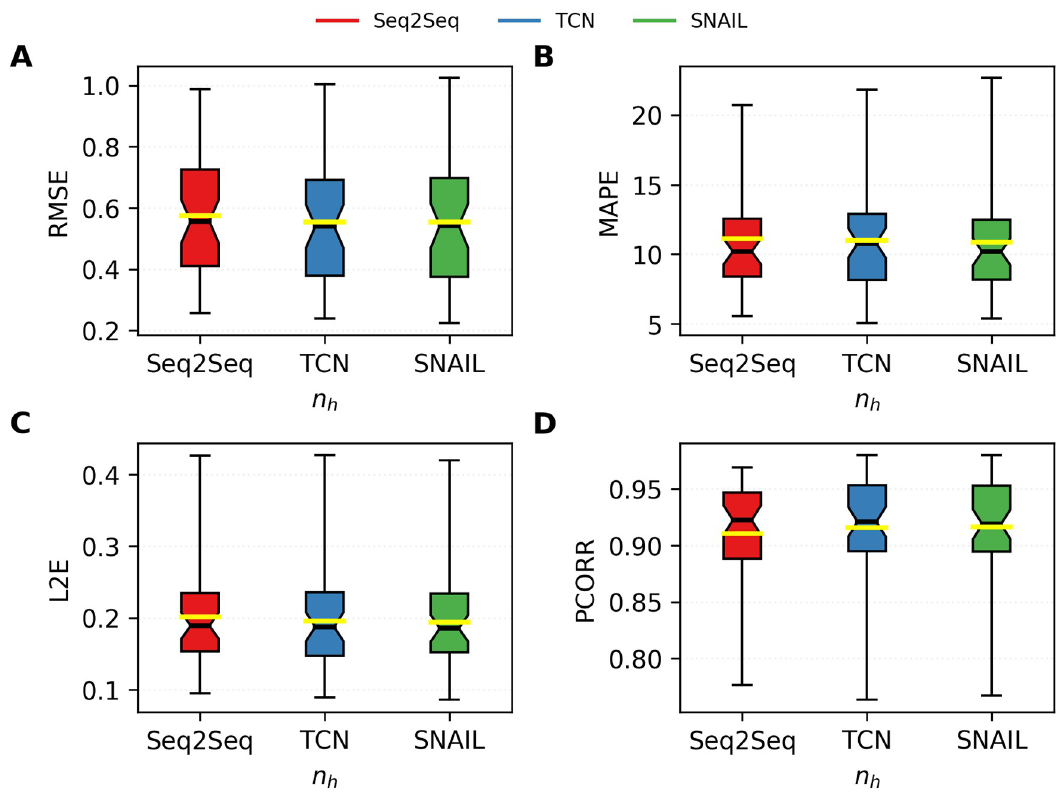
Fig 12. The boxplots of all four performance metrics measured by using Seq2Seq, TCN, and SNAIL. A. RMSE, B. MAPE, C. L2E, and D. PCORR. The boxplots summarize statistics of the predictions made for every 49 states. The middle black and yellow lines indicate medians and means, respectively, and the boxes indicates the interquartile